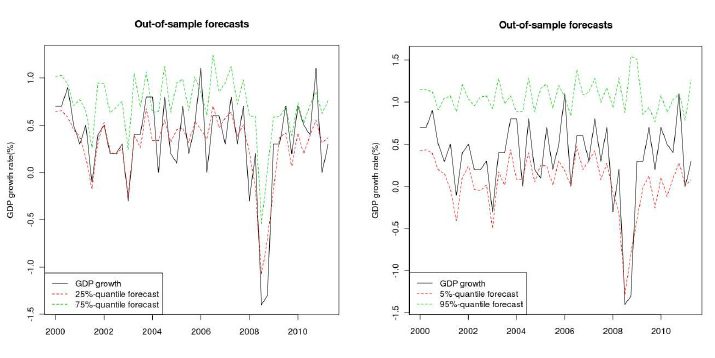
Fig 2. French GDP online 50% -confidence intervals (left) and 90% -confidence intervals (right).